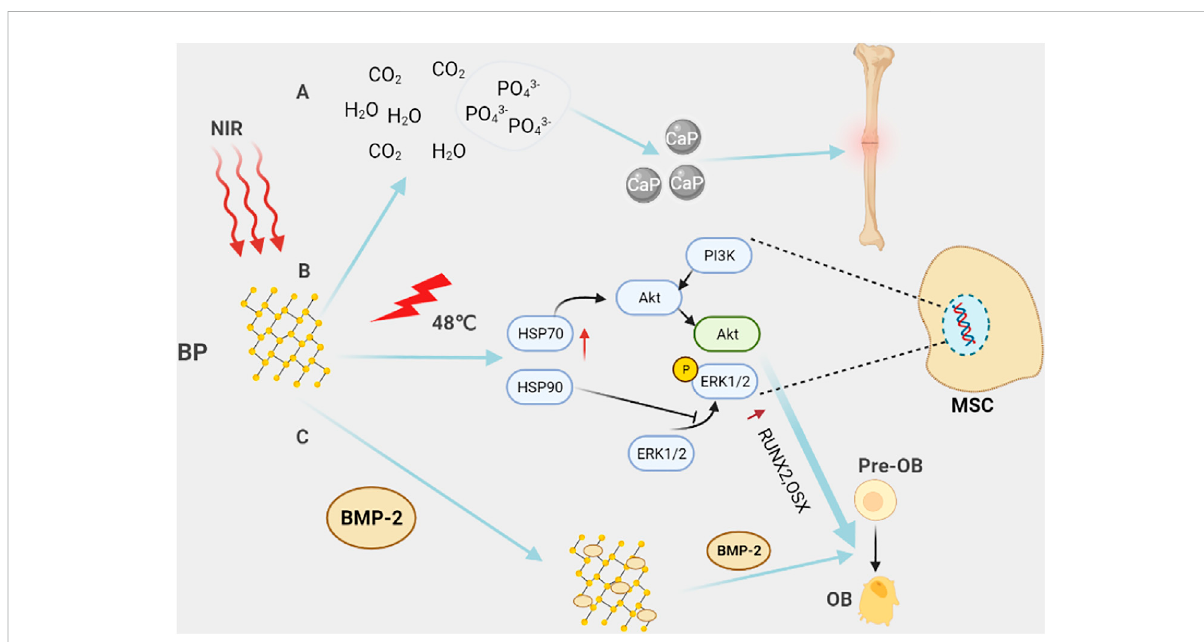
FIGURE 5 Black phosphorus in bone tissue engineering. (A) Black phosphorus is completely degraded in the body into harmless H 2 0, CO 2 , and PO 4 3- . PO 4 3- is one of the basic components of the bone matrix, which is bene fi cial to promote bone repair. (B) Under NIR light, BP locally generates heat through the photothermal effect, activates heat shock proteins, and then promotes the expression of osteogenic-speci fi c genes, such as RUNX2, BMP2, andthedifferentiationofpre-osteoblastsintoosteoblaststhroughactivating ERK1/2signaling pathway and PI3K/AKT signaling pathway. (C) Withtheirunique structure, black phosphorus nanosheets cancarryBMP2,etc., andregulateboneformationinthebone microenvironment.For example, BMP2 promotes the differentiation of pre-osteoblasts into